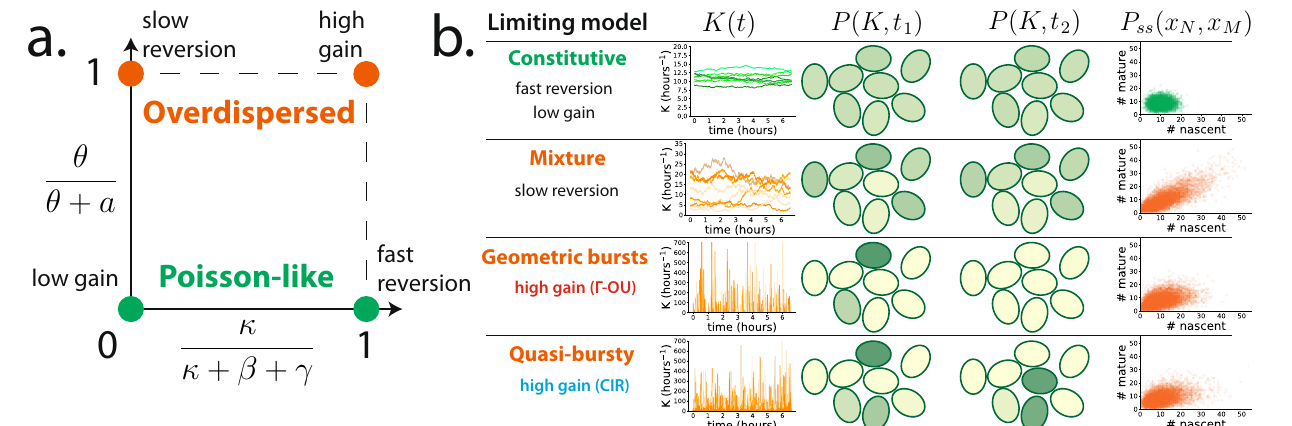
count distribution are depicted in the rightmost column. Both models reduce to the constitutive model in the fast reversion and low gain limits, where the tran- scription rate K ( t ) is effectively constant in time and identical for all cells in the population. Both reduce to the mixture model in the slow reversion limit, so that K ( t ) is inhomogeneous across the population but constant in time for individual cells. In the high gain limit, the Γ -OU and CIR models yield different heavy-tailed distributions,withtheCIRlimitingmodelappearingtobeuncharacterized.Inboth cases, K ( t ) exhibits sporadic large fl uctuations within single